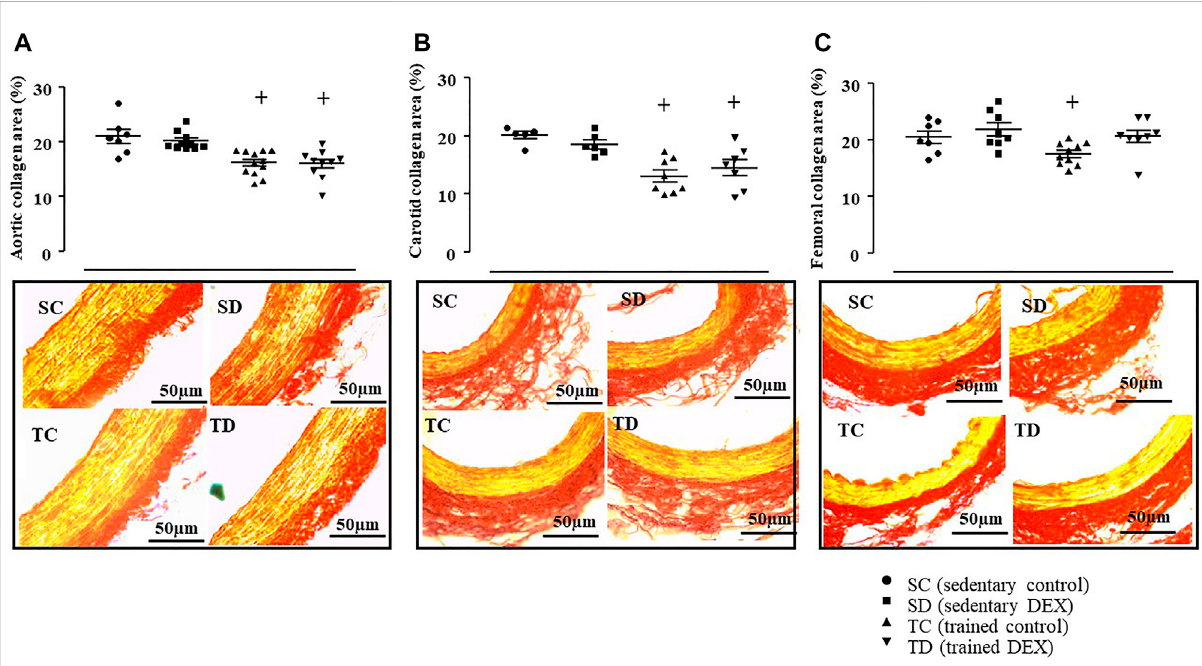
FIGURE 6 Values of collagen deposition area: aorta artery (%, Panel (A) , carotid artery (%, Panel (B) and femoral artery (%, Panel (C) in all SHR groups: Sedentarycontrol(SC, n =7),SedentarytreatedwithDEX(SD, n =10),Trainedcontrol(TC, n =12),TrainedtreatedwithDEX(TD, n =10).Signi fi cance: +vs . Sedentary; p < 0.05.Representativeimagesofcollagendepositionareaonaorta,carotid,andfemoralarteries.Cross-sections(5 μ m)takenfrom one animal of each group stained with Picrosirius-red. Stained in yellow represents the smooth muscle fi bers and stained in red represents the collagen fi bers. Bar: 50